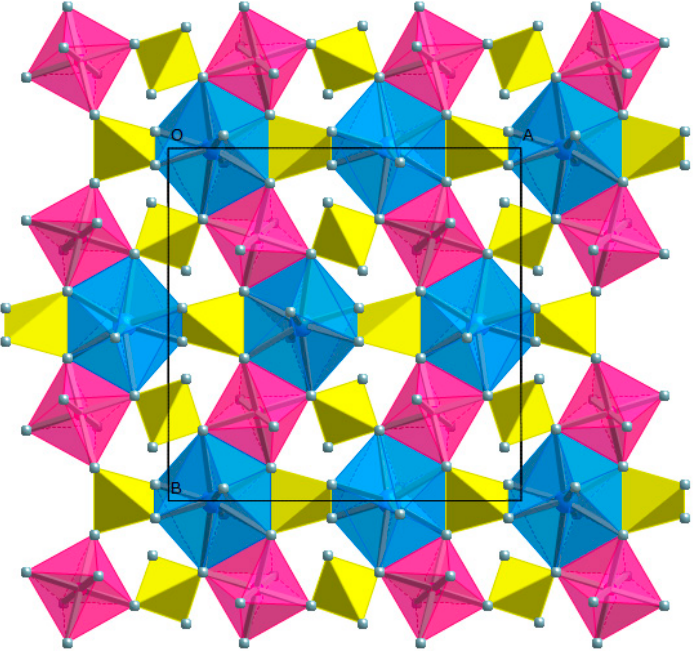
Figure 1. Projection of the pyrope structure down the c axis showing the X (=Mg) dodecahedra (blue), Y (=Al) octahedra (pink), Z (=Si) tetrahedra (yellow), and O atoms (gray spheres). The edge-sharing and zig-zag arrangement of alternating octahedra and dodecahedra are indicated. The labels indicate the following: O is the origin, OA is along the a-axis, and OB is along the b-axis.